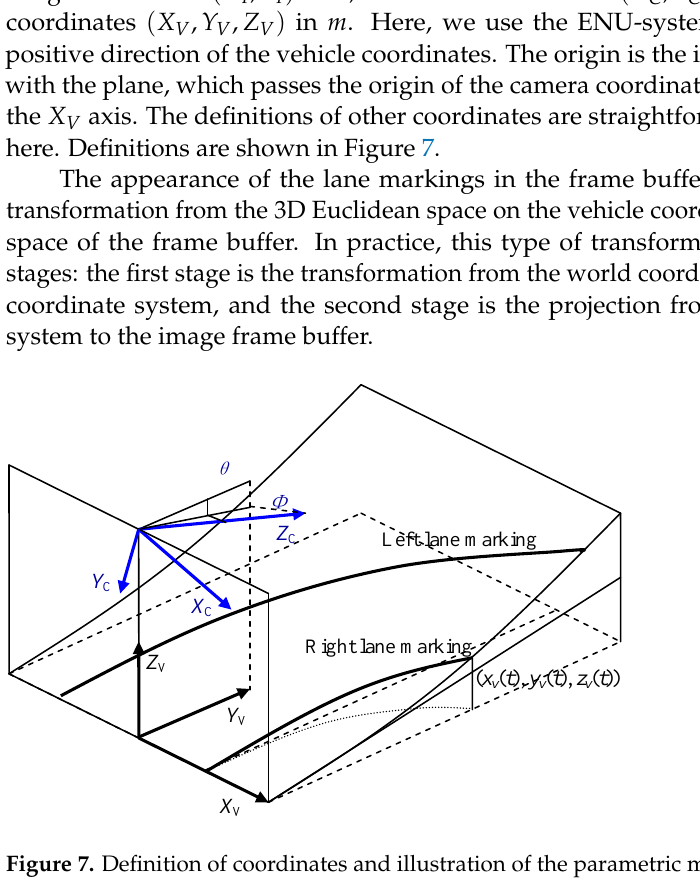
Figure 7. Definition of coordinates and illustration of the parametric model of lane